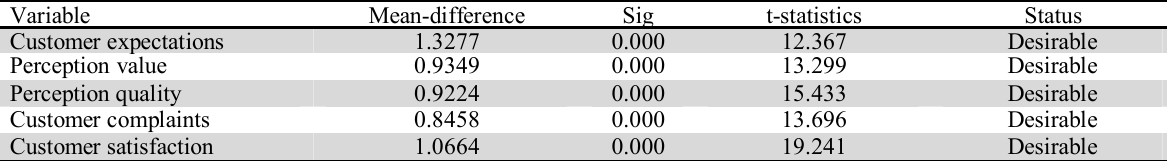
The results of mean-difference as well as t-student for the second hypothesis of the survey Variable